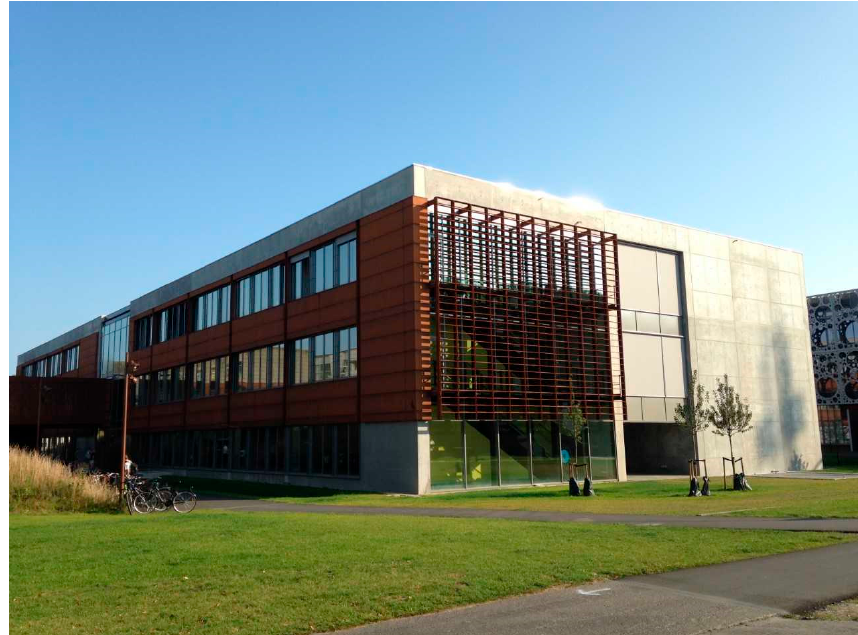
Figure 1. The OU44 building located at the University of Southern Denmark Campus Odense seen from southwest.